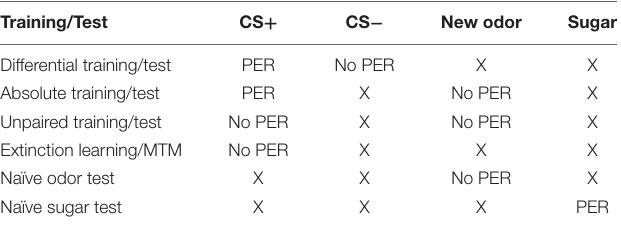
TABLE 1 | Evaluation of correct behavioral responses in the analyzed data